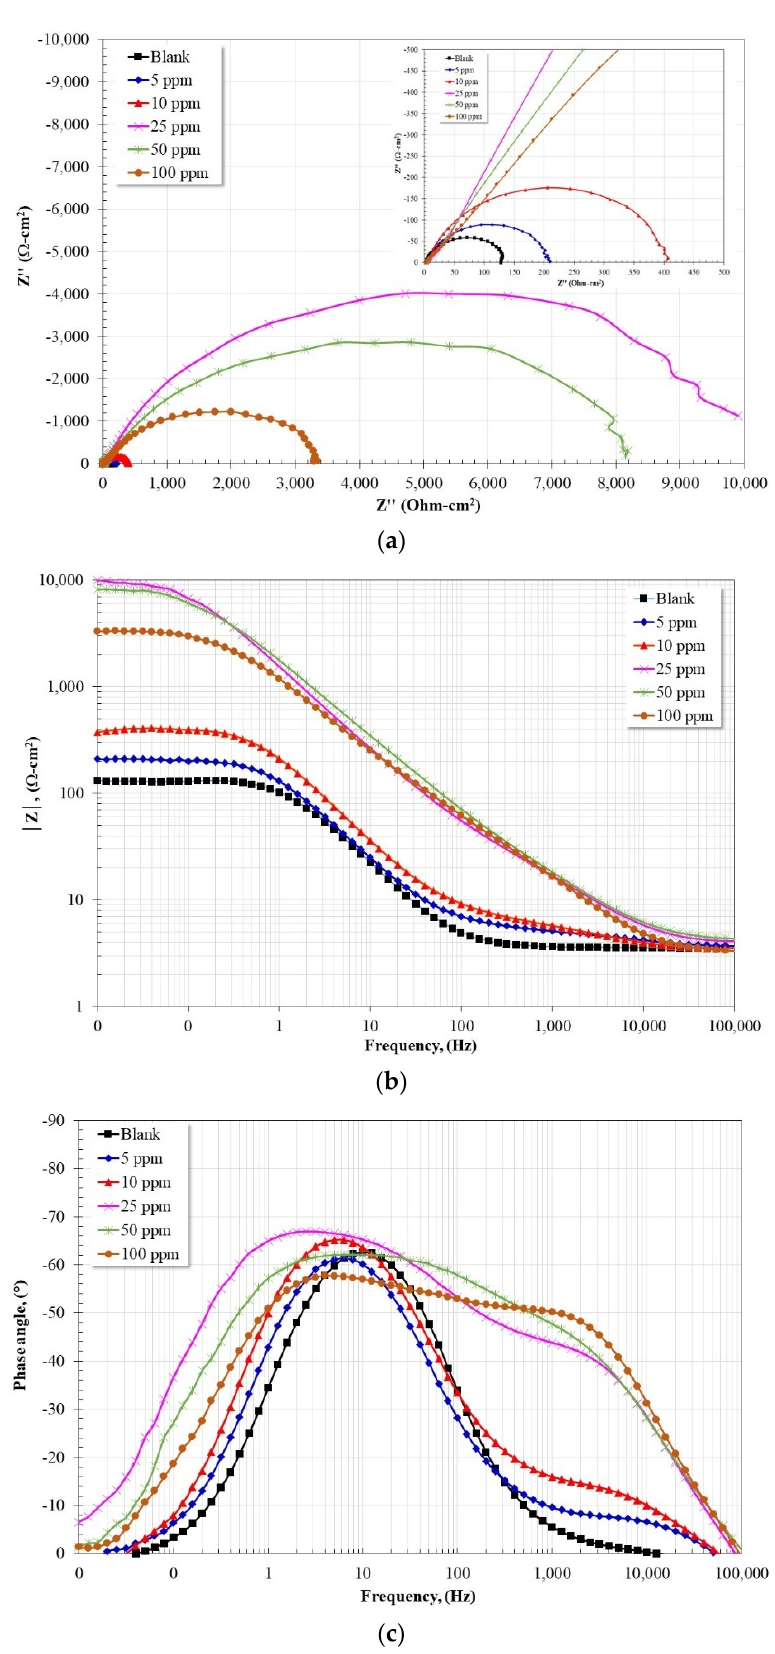
Figure 4. Nyquist ( a ) and Bode ( b , c ) plots for API-X52 steel in CO 2 -saturated brine after 24 h immersion at 60 °C, with and without inhibitor addition.